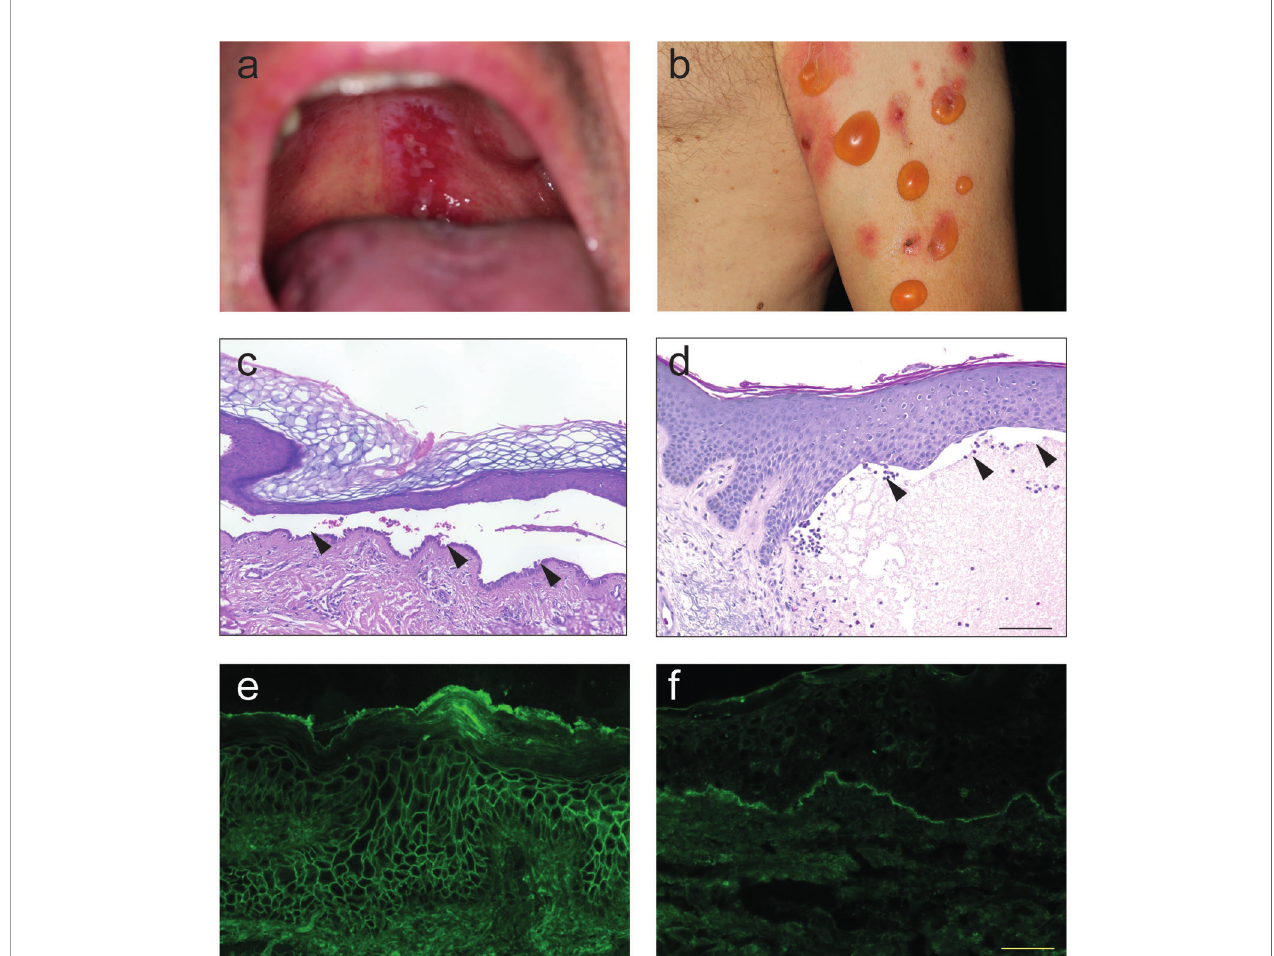
FIGURE 2 | Clinical, histological and immunological features of pemphigus and pemphigoid. (A) Clinical presentation of pemphigus vulgaris with erosions at the upper palate. (B) Clinical presentation of bullous pemphigoid with blistering at erythematous or otherwise apparently healthy skin. (C) Lesional histopathology of a patient with pemphigus vulgaris showing suprabasal splitting with some acantholysis and the typical “ row of tombstones ” (arrows). (D) In a lesional biopsy of a patient with bullous pemphigoid, subepidermal splitting. In this case, interestingly, the dermal in fi ltrate is only marginally present. (E) Tissue-bound IgG in a perilesional skin biopsy of a pemphigus vulgaris patient, showing IgG deposits in a honeycomb-like pattern within the epidermis. (F) Tissue-bound IgG in a perilesional skin biopsy of a bullous pemphigoid patient, showing linear IgG deposits along the dermal-epidermal